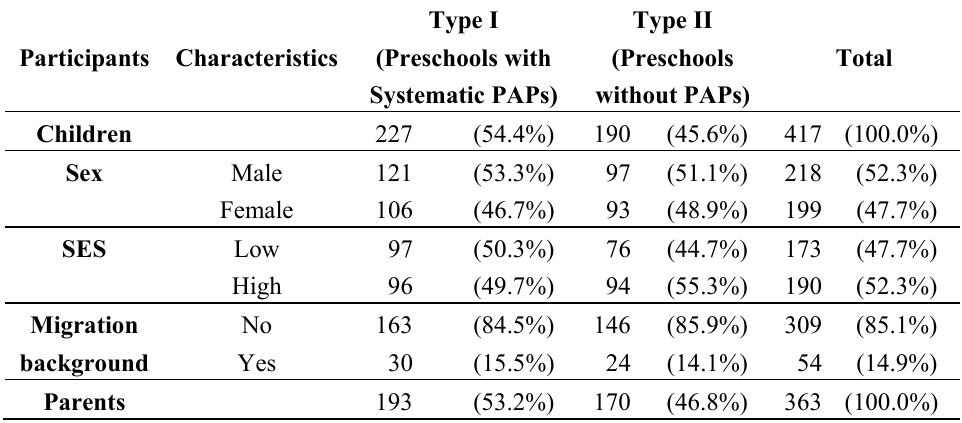
Table 1. Descriptive characteristics of participants by preschool